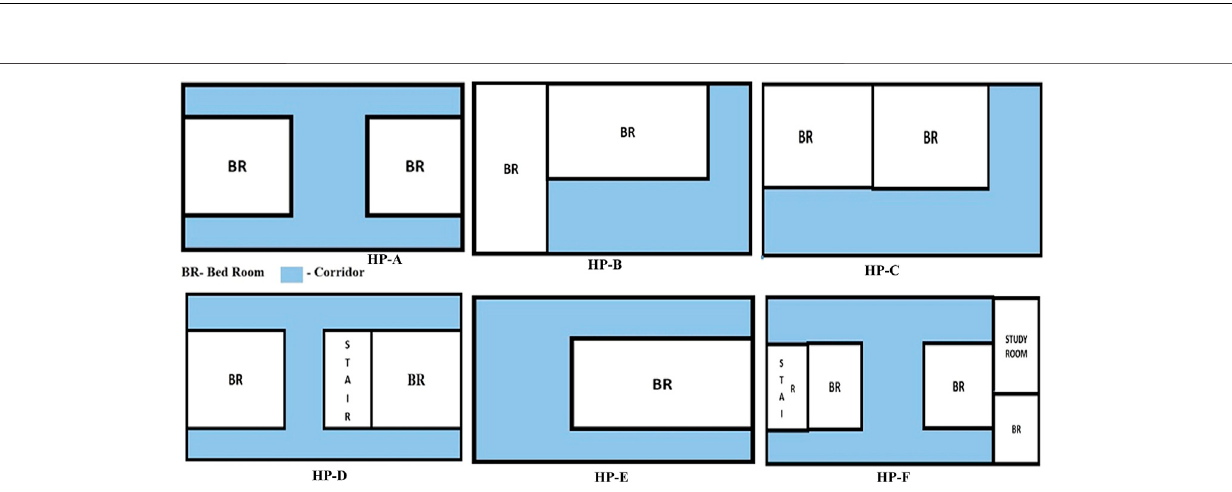
FIGURE 4 | Dwelling patterns (inner structure) of remote rural, rural, and semi-urban areas.